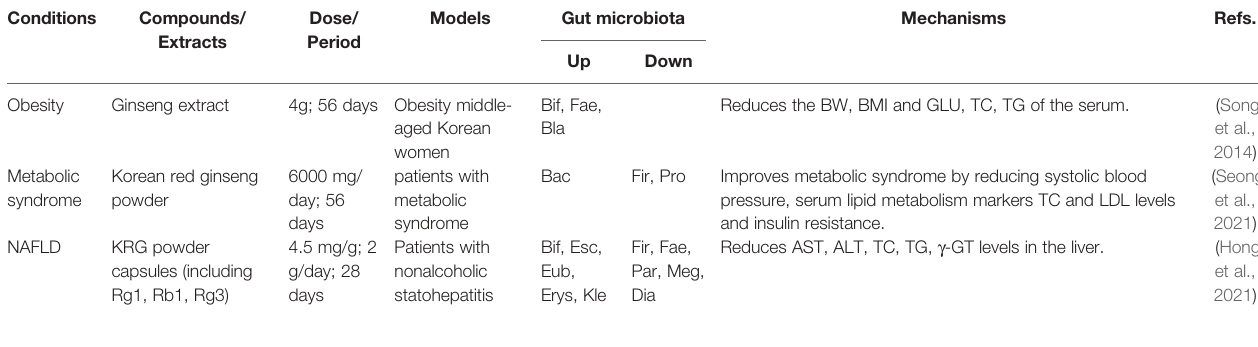
TABLE 2 | Summary of ginseng regulating gut microbiota in human